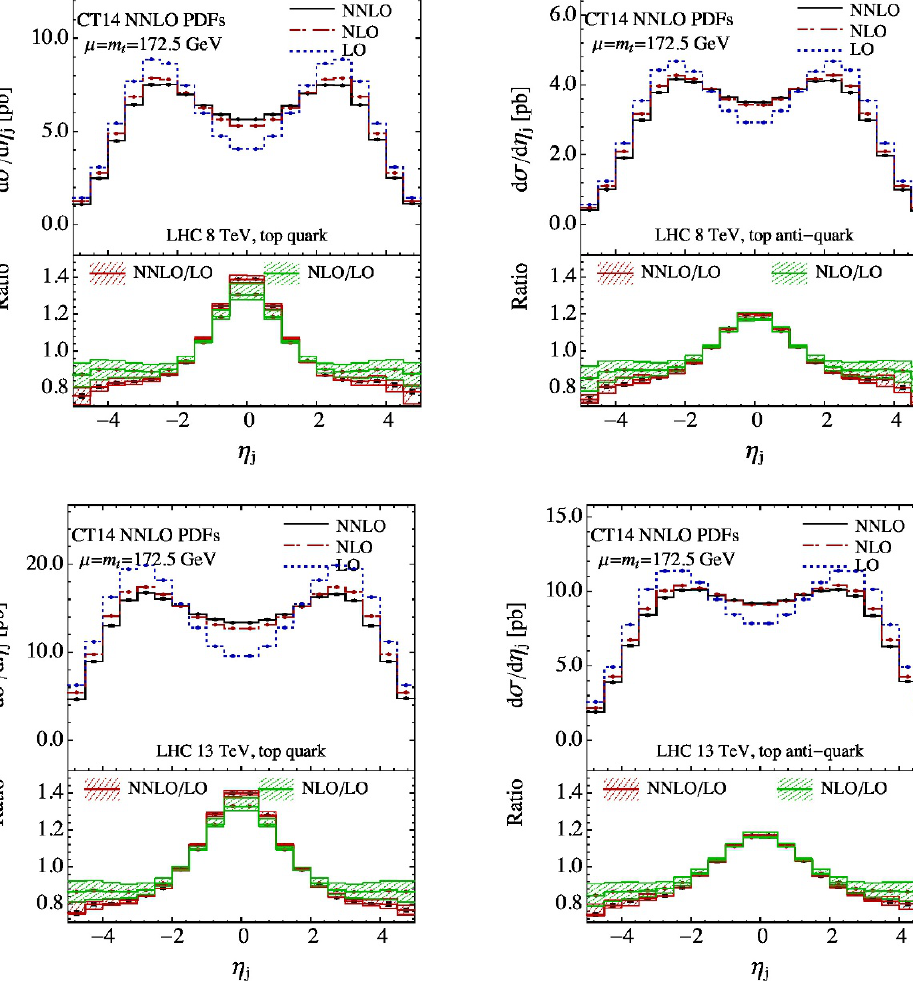
Figure 22 . Predicted pseudorapidity distribution of the leading-jet from t -channel single top-quark production at the LHC 8 and 13